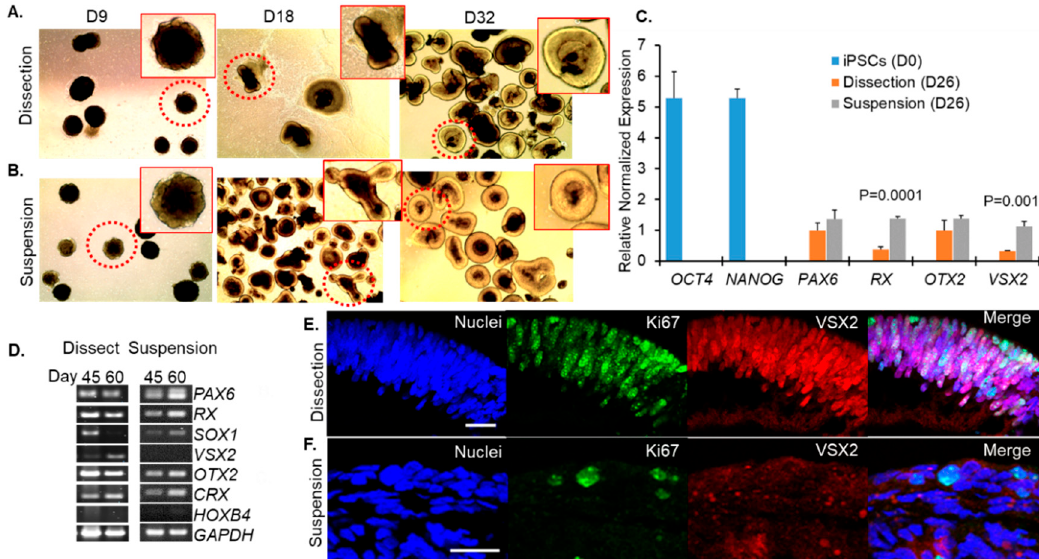
Figure 2. Optic vesicles were identified for ( A ) the dissection and ( B ) suspension protocols. iPSCs lose pluripotency and express eye field transcription factors by day 26 of differentiation. ( C ) RT-qPCR normalized to GAPDH and β -actin on iPSCs and D26 optic vesicles developed using dissection or suspension protocols. ( D ) RT-PCR showing expression of neuroretina progenitors at days 45 and 60 for both methods of differentiation. Representative images from ICC for D50 retinal organoids that were fold homeobox (RX) and paired box-6 (PAX6) was detected by D26 in both dissection and suspension groups but not D0 iPSCs, indicating specification of the eye-field (Figure 2C). The earliest specific indicator of neural retina progenitor cells is expression of the gene visual system homeobox 2 (VSX2) which was expressed by developing retinal ( E ) dissected or ( F ) grown in suspension. Scale bar 20 μ m.